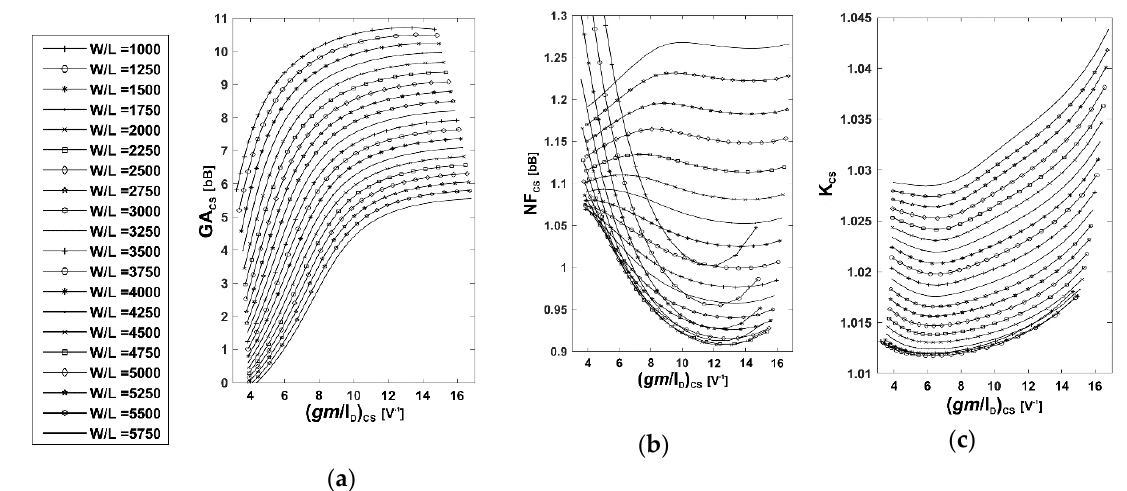
Figure 10. CS stage response as a function of the gm / I D : ( a ) gain; ( b ) noise figure; ( c ) stability factor K .